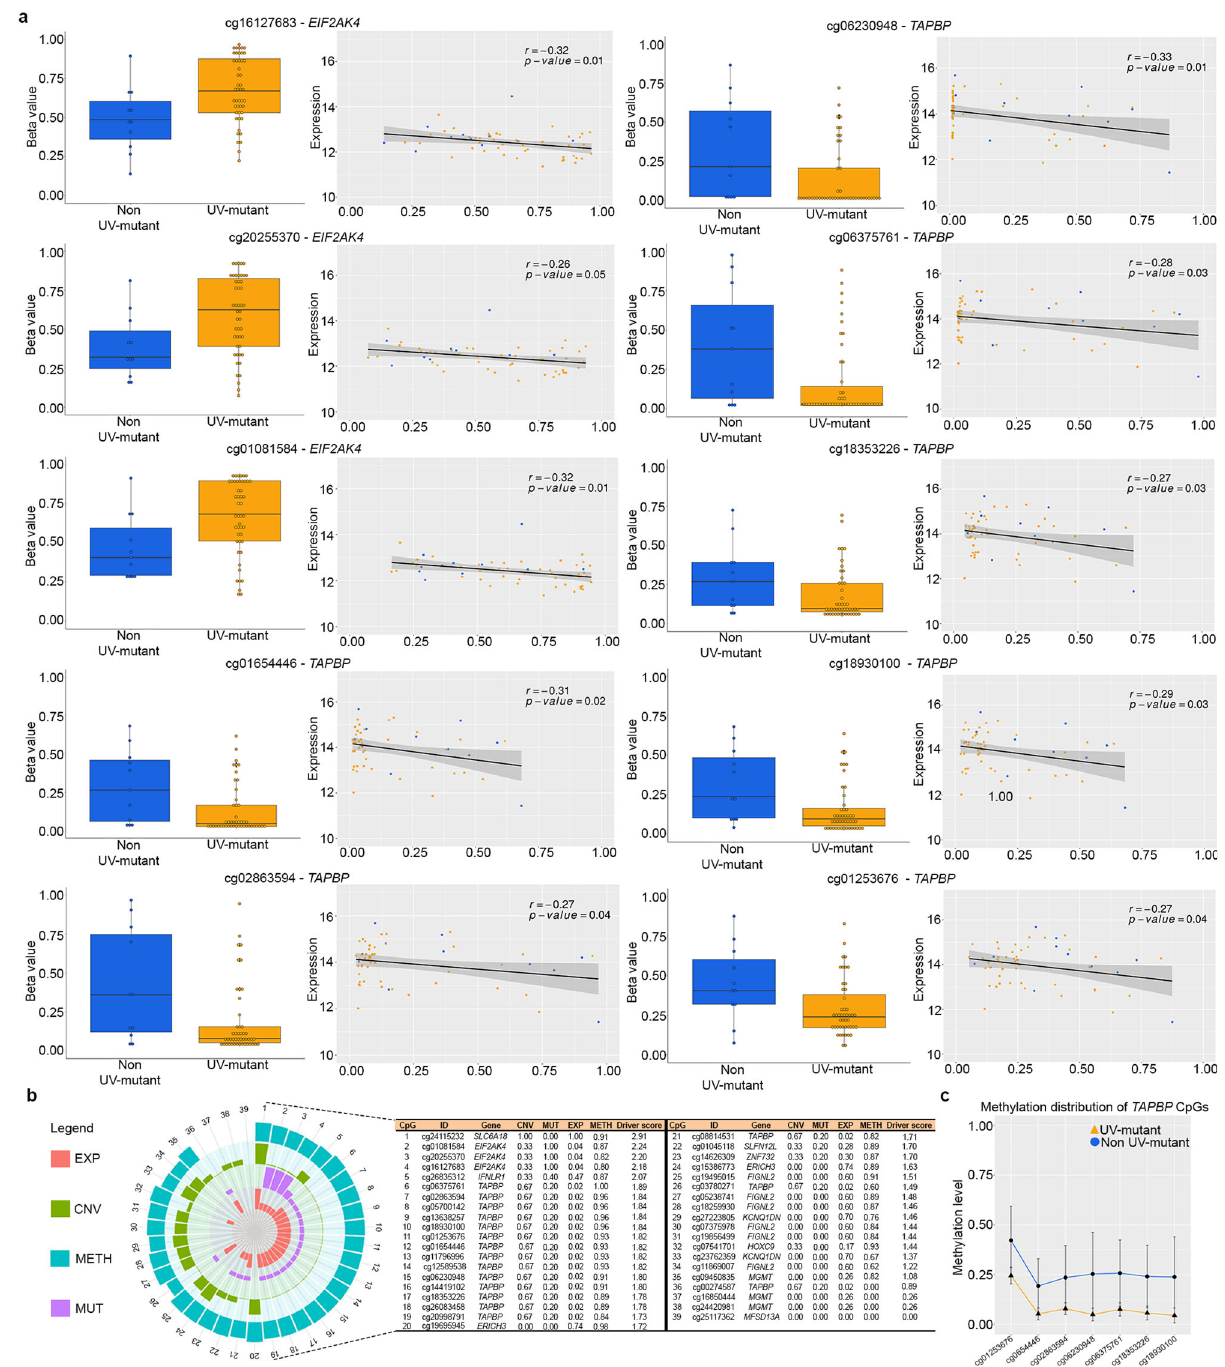
Fig. 5 Validation, eQTM, and multi-OMICs cancer driver analysis of UV methylome markers. a Pearson correlation was used to measure linear relationships between DNA methylation (Beta values) and gene expression levels measured in the same samples for the 10 selected CpGs ( fi ltration step described in Supplementary Fig. 1a), using the TCGA dataset (UV-mutant = 11 and non UV-mutant = 47). Box center lines, bound of the box, and whiskers indicate medians, fi rst and third quantiles, and minimum and maximum values within 1.5 × IQR (interquartile range) of the box limits, respectively. Each data point in the box plot represents the samples. The correlation r and P values were calculated by the two-sided correlation test and are shown for each CpG. b Multi-OMICs data integration from TCGA, encompassing copy number variation (CNV), expression (EXP), methylation (METH) and mutation (MUT), was performed in order to decipher the driver potential of the 12 prioritized genes (see Results) in cutaneous melanoma development following UV exposure. For each gene, scores of CNV, MUT, EXP, METH and multi-OMICs driver are indicated in the table and plotted in the associated circular diagram. c Validation of array-based DNA methylation by bisul fi te pyrosequencing of the TAPBP gene in BCH samples (UV-mutant = 7 and non UV-mutant = 40). Data were expressed as the average values of each group (UV-mutant and non UV-mutant) for each single CpG with error bars indicating the 95% con fi dence